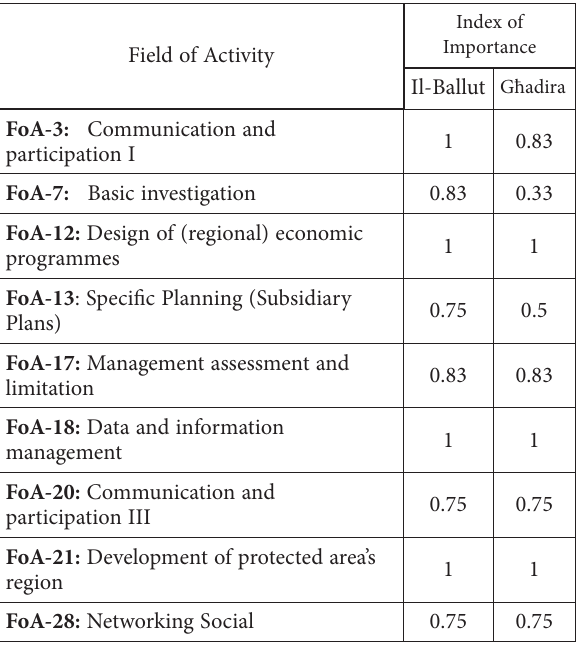
Table 2. Critical fields of activity in life-cycle management